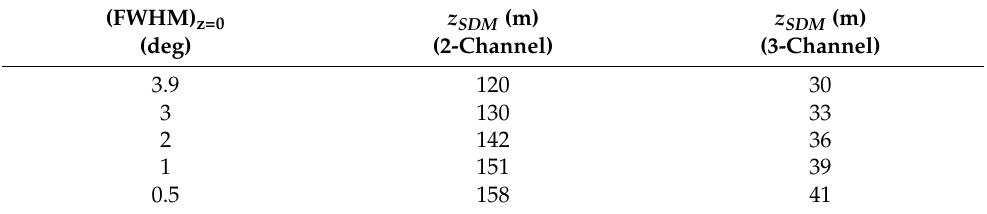
Table 2. Length z SDM for two and three spatially multiplexed channels with minimal crosstalk in SI air- clad silica optical fibers for different widths ((FWHM) z=0 ) of the Gaussian launch beam distributions. (FWHM) z=0 z SDM (m) z SDM (m) (deg) (2-Channel) (3-Channel) 3.9